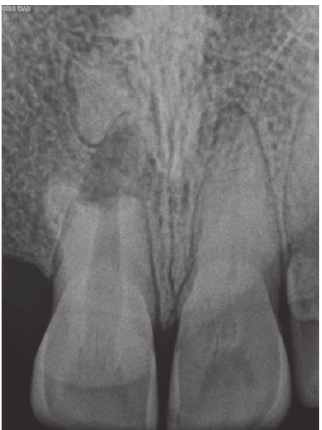
Figure 1: Preoperative intraoral periapical (IOPA) radiograph showing open apex in relation to